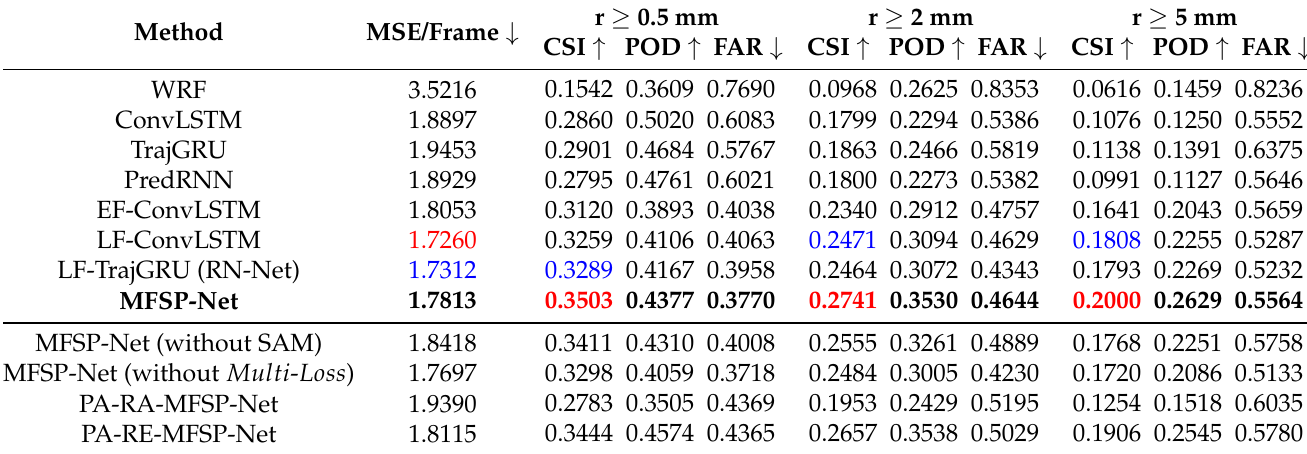
Table 6. Average evaluation results of four frames of precipitation amount nowcasting in the four